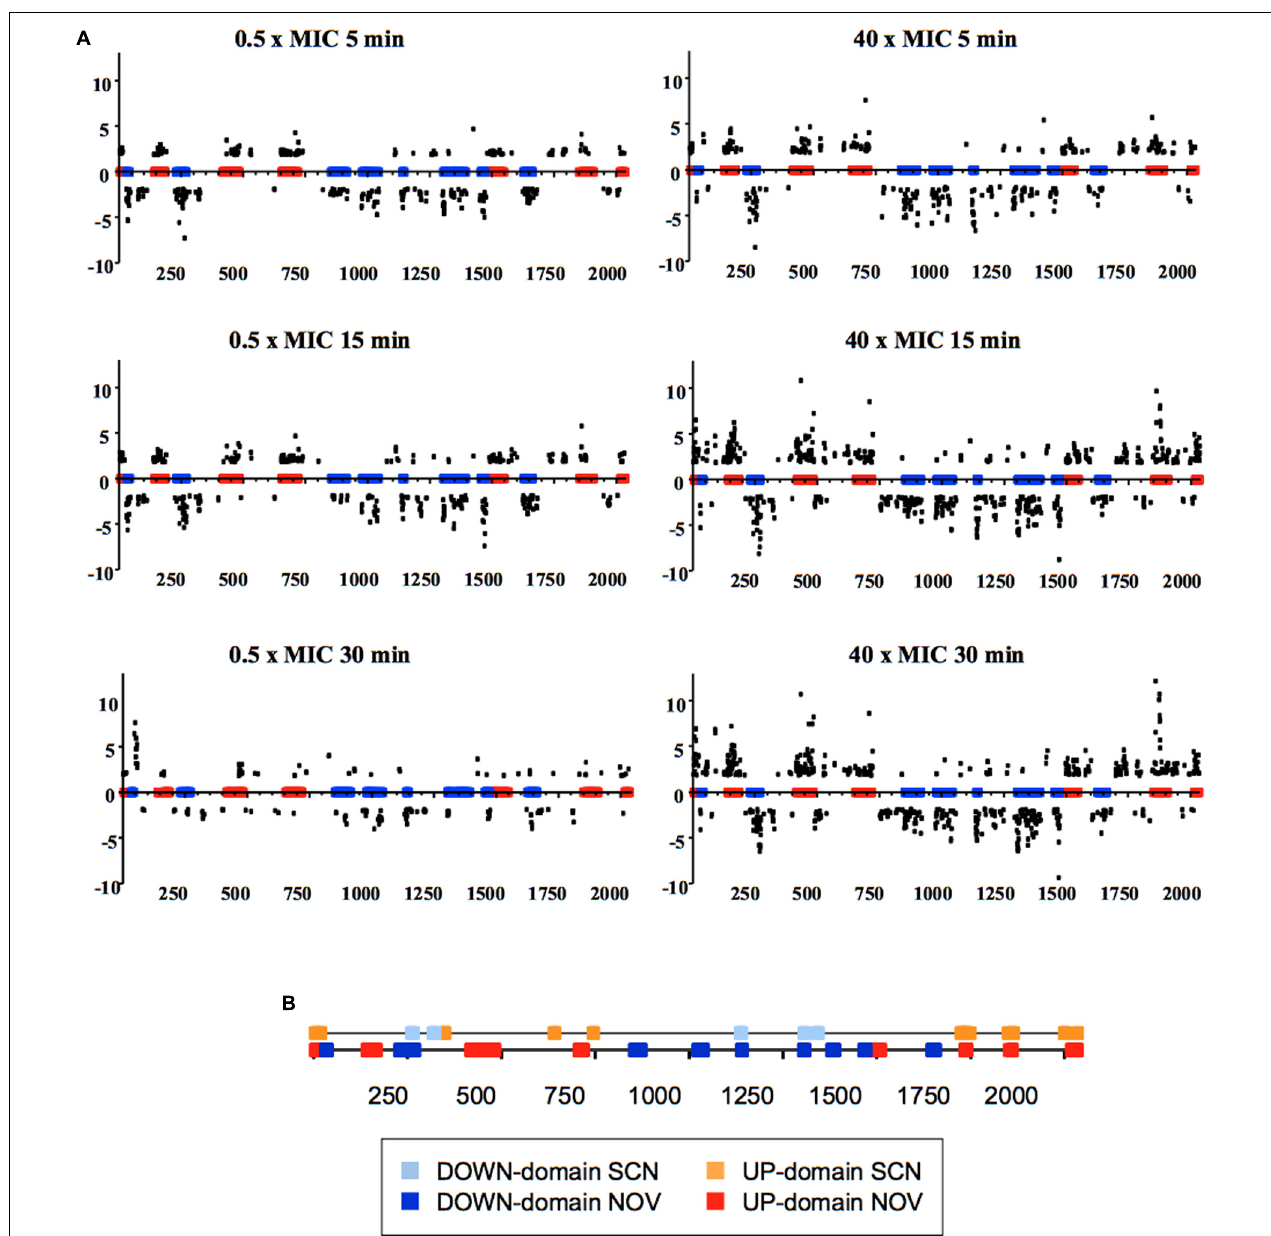
FIGURE 4 | Global transcriptomic responses of S. pneumoniae to relaxation with NOV. (A) The relative fold variation of each gene is represented against the 3 (cid:48) location of each open reading frame in the S. pneumoniae R6 chromosome (bases 1 to 2,038,615). Boxes indicate the transcriptional clusters: up-regulated in red, down-regulated in blue. (B) Localization of topological clusters detected as a result of treatment with either SCN or NOV. Taken from Ferrándiz et al. (2010, 2016a), with